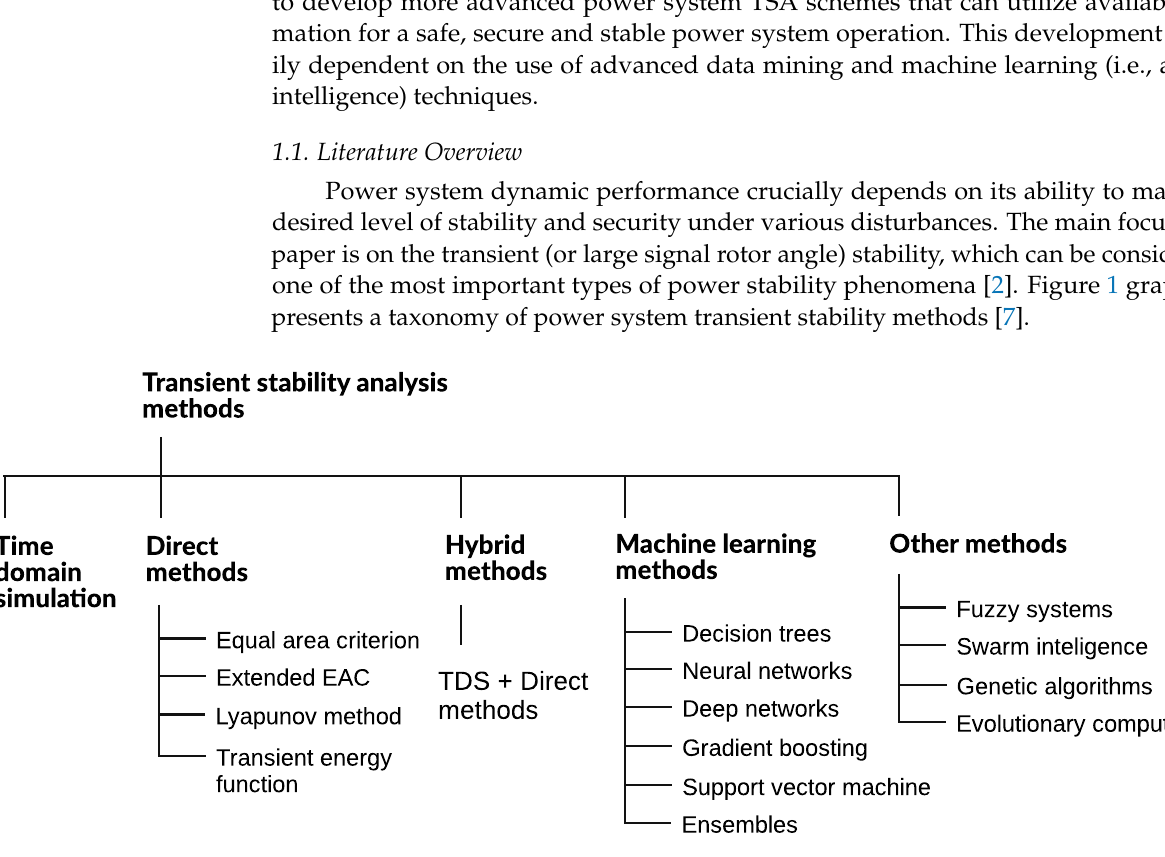
Figure 1. A taxonomy of power system transient stability analysis